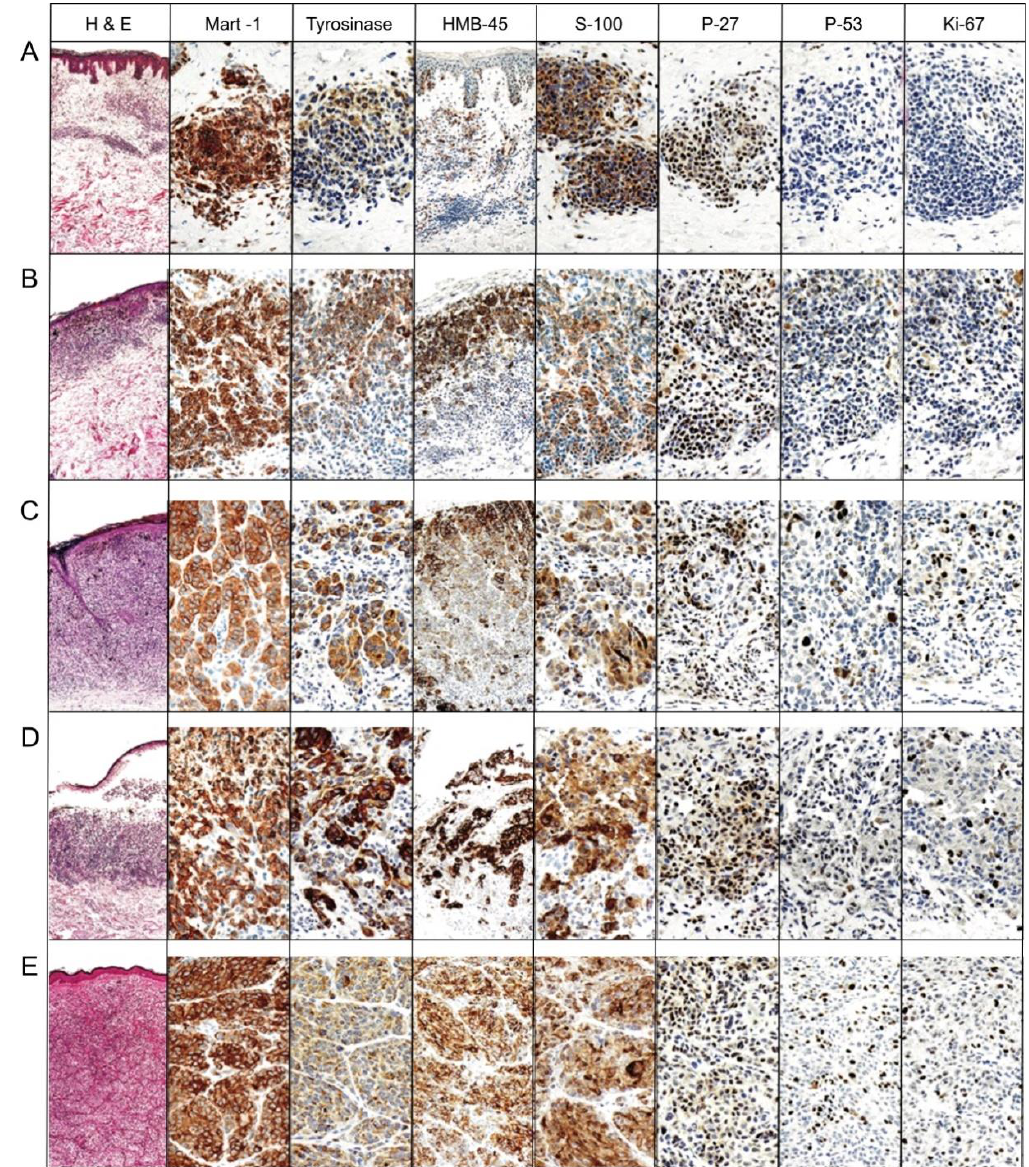
Figure 12. Immunohistochemical stains of five different lesions. Six different stains were applied to five different histologic sections including ( A ) intradermal nevus, ( B ) dysplastic (Clark’s) nevus, ( C ) nevoid melanoma, ( D ) NOS (Not otherwise specified) primary melanoma, ( E ) metastatic melanoma. Stain types included hematoxylin and eosin (H&E), MART-1, Tyrosinase, HMB-45, S-100, P-27, P-53 and K-i67. In melanoma, HMB-45 showed a staining of deeper cells, as compared to the primarily superficial staining that is seen in both benign and dysplastic nevi. The P-53 marker shows positive staining in melanomas but was also positive in dysplastic nevi, while not staining positively in common nevi. Ki-67 demonstrated deeper staining in the bottom of melanoma lesions, while showing positive staining primarily in the junctional melanocytes of the common nevi. With positivity in both melanomas and common nevi, P-27 is a poor distinguishing marker. The following markers were photographed by the original author at 100× the original magnification: Tyrosinase, S-100, p-27, p-53, Ki-67 and MART-1 (Melanoma antigen recognized by T-cells). HMB45 stain was photographed by the original author at 40× of the original magnification. All of the H&E images were photographed by the original author at 20× [128] . Reproduced from Ohsie et al. from the Journal of Cutaneous Pathology with permission from publisher John Wiley and Sons, [128]).